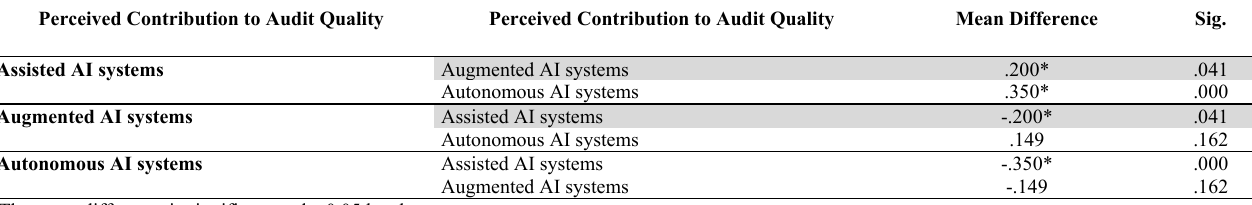
One-way repeated measures ANOVA for perceived contribution to audit quality Perceived Contribution to Audit Quality Perceived Contribution to Audit Quality Mean Difference